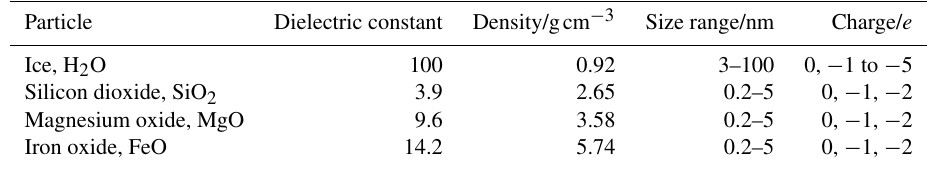
Table 1. Common particulates found in the MLT region which are considered in this study.